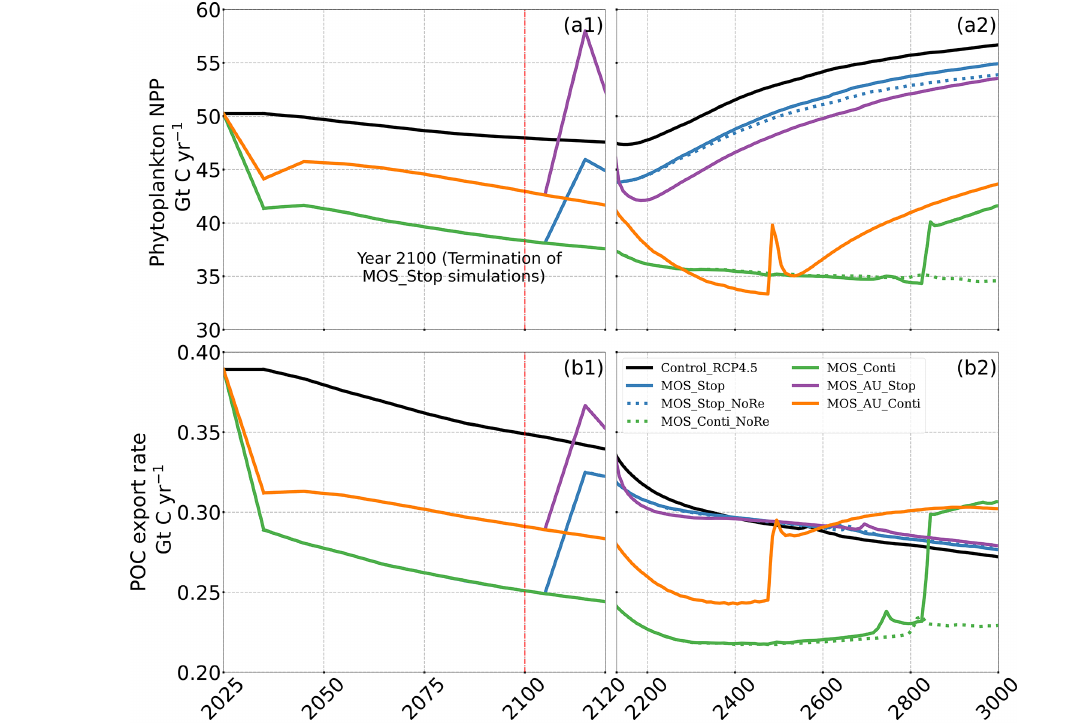
Figure 9. Temporal evolution of globally integrated PNPP (a1, a2) ; downward POC flux at 2km depth (b1, b2) . The termination runs branch off of the continuous ones in year 2100 and are identical up to that point. Through the 21st century, MOS reduces PNPP and POC export due to canopy shading and competition for nutrients. Obvious rebounds followed by quick decline can be observed right after terminations of